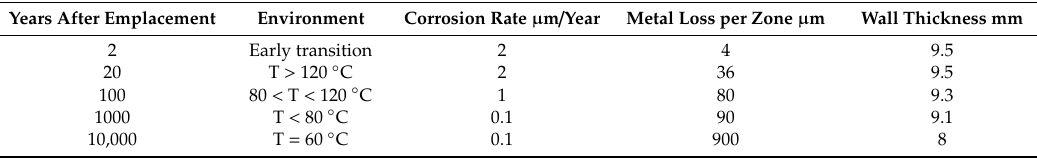
Table 4. Corrosion of Alloy 625 canisters: metal penetration per zone and remaining wall thickness.